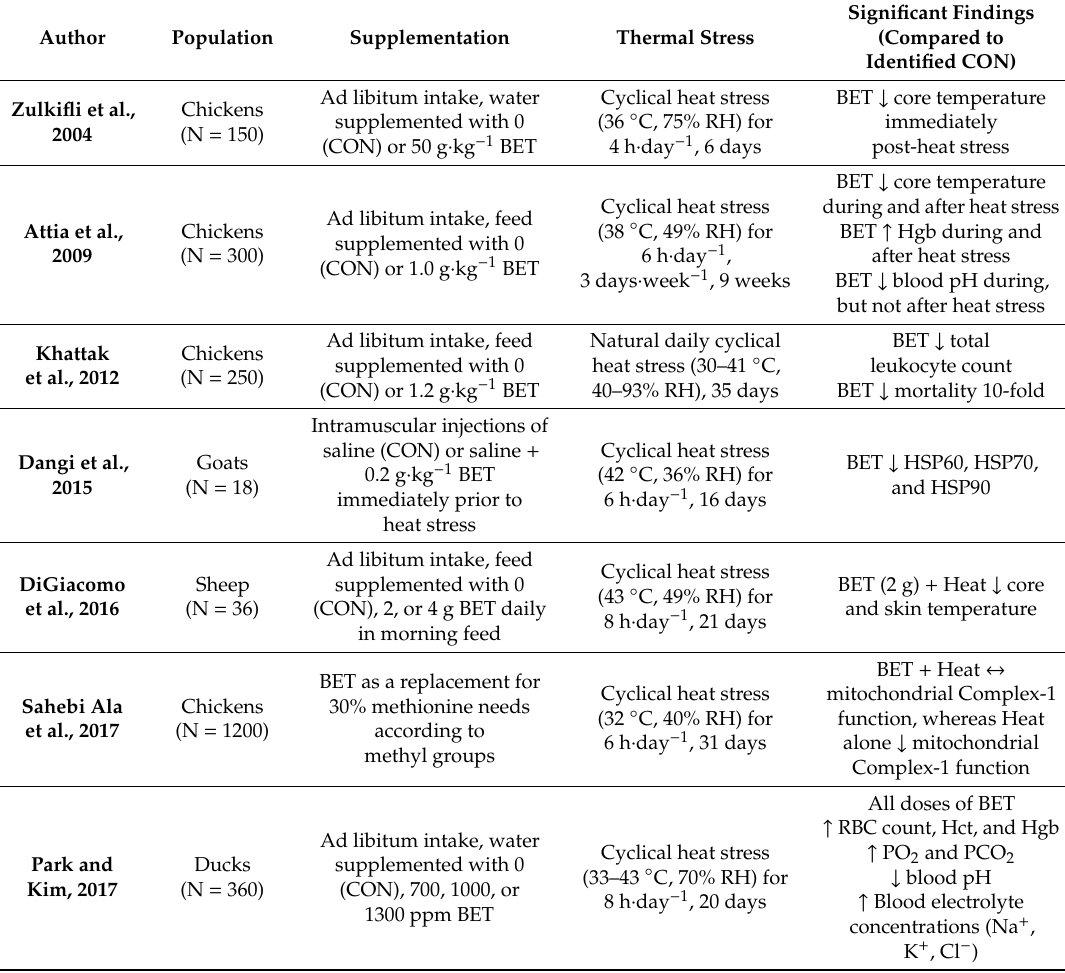
Table 1. Animal models successfully using BET to combat passive thermal